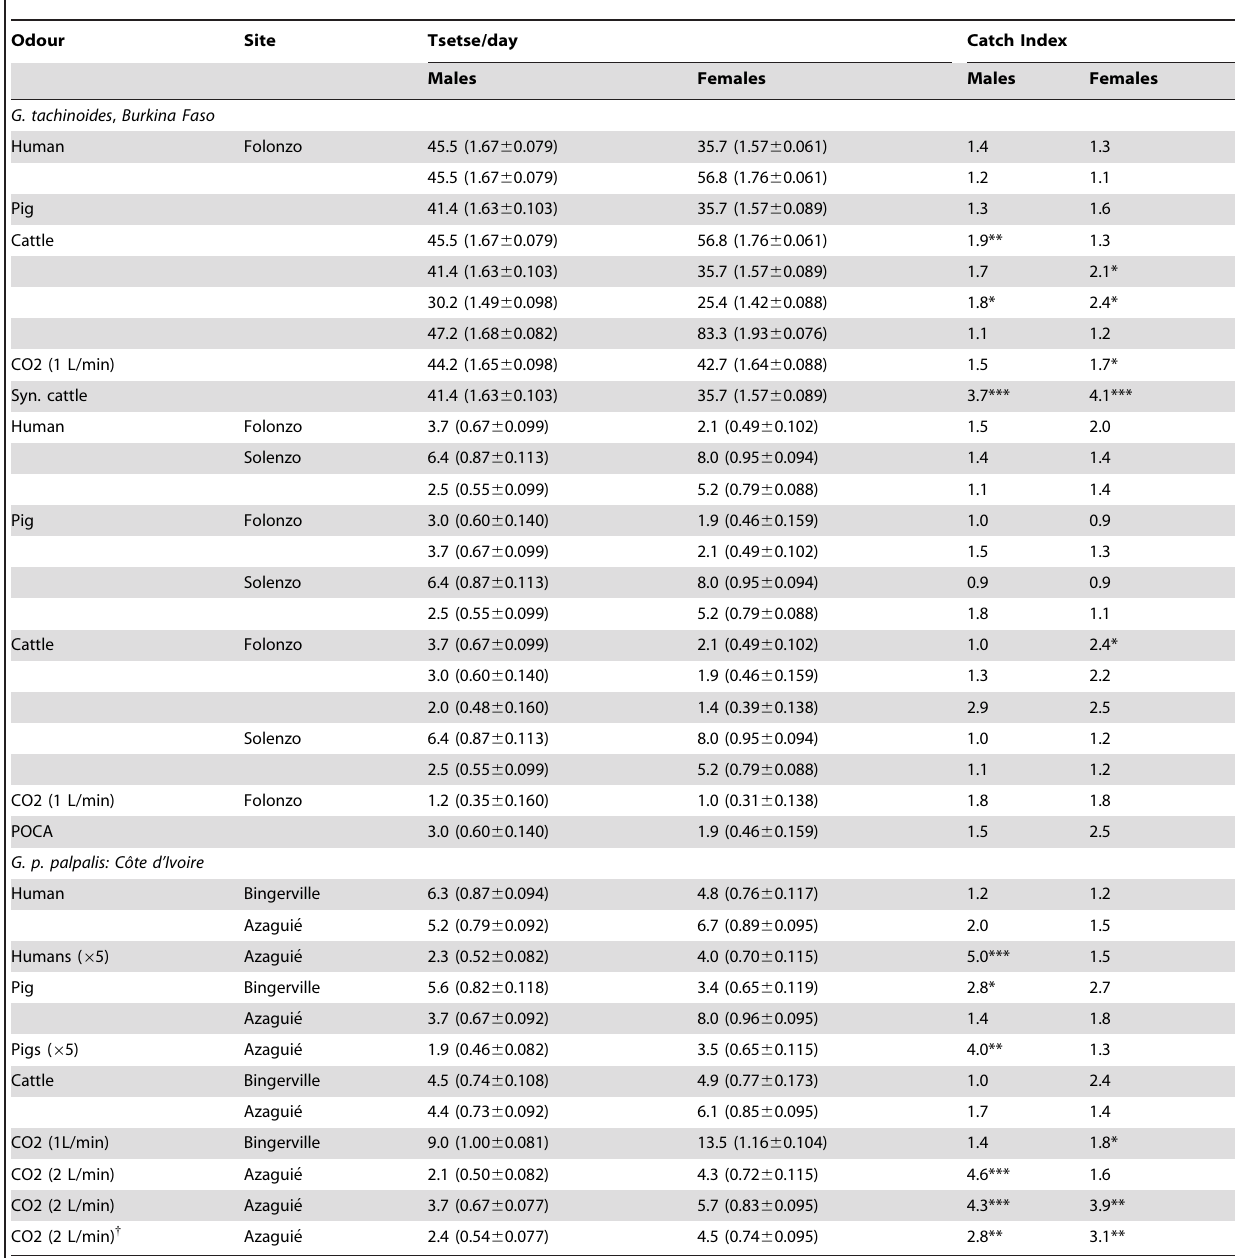
Table 2. Detransformed mean daily catches (transformed means 6 SED in brackets) of G. tachinoides , G. p. gambiensis and G. p. palpalis from odour-baited electrocuting devices (E-net + E-target) expressed as a proportion (Catch Index) of that from an unbaited E-net +